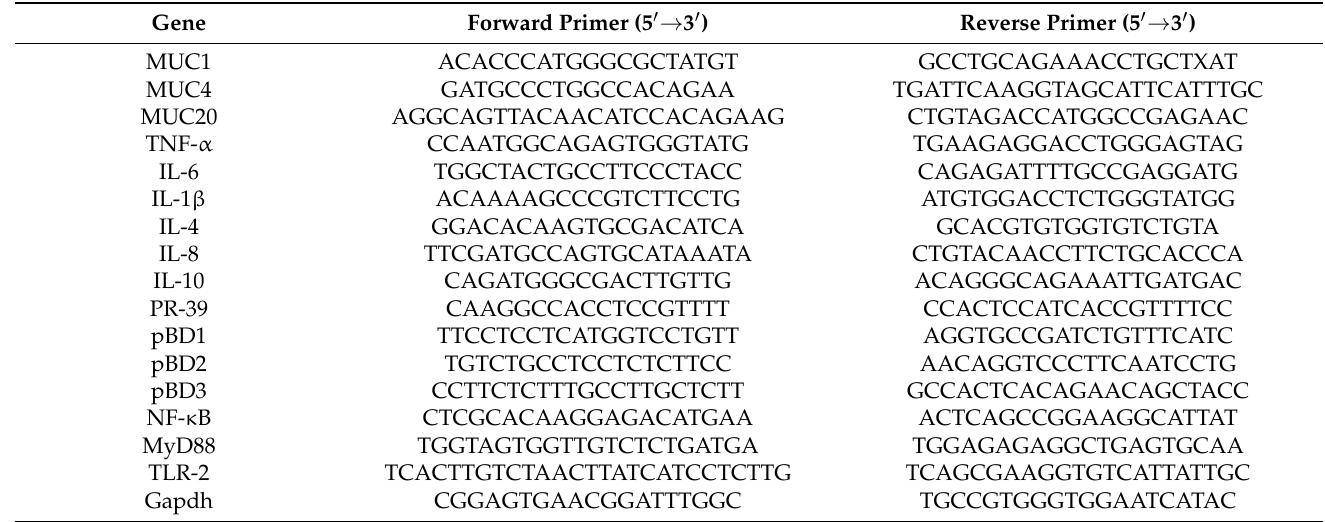
Table 3. Specific primers used for real-time